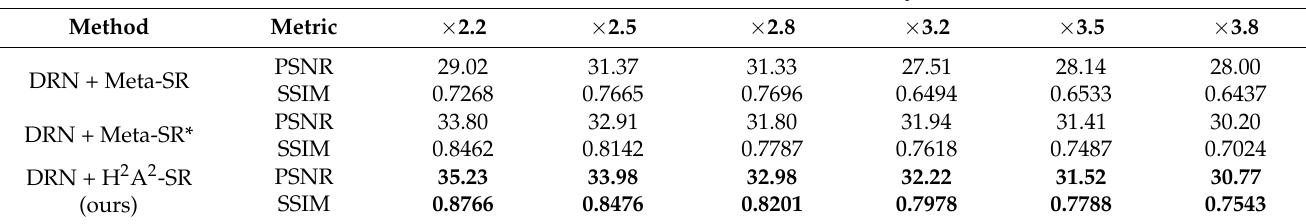
Table 4. Comparison of the quantitative quality arbitrary super-resolution models in terms of PSNR (dB) and